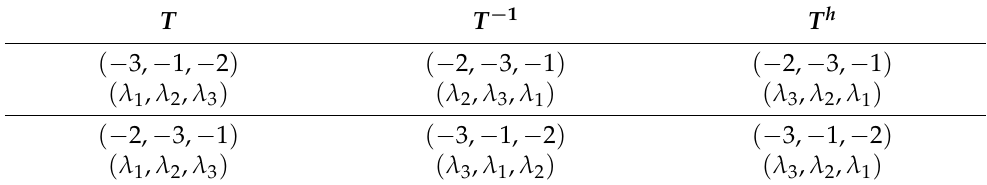
Table 5. 3-IETs with three